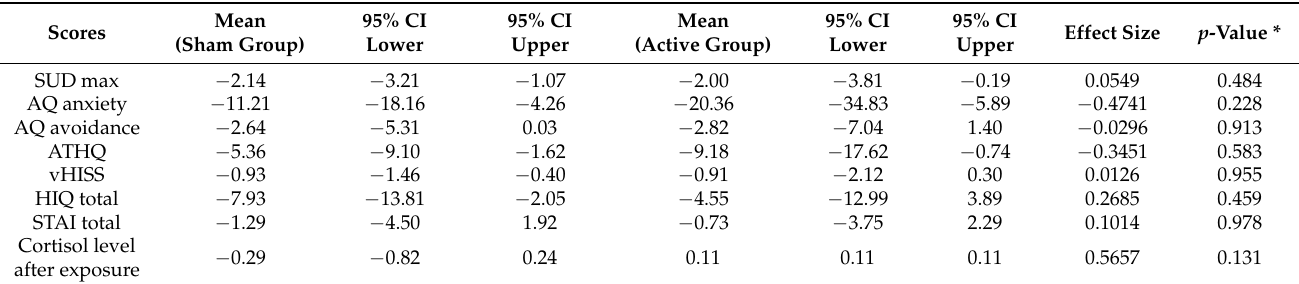
Table 4. Mean individual changes between V1 and V4 for each score in both group with 95% CI and effect size (a positive effect in the sense of active tDCS and a negative one in the sense of sham